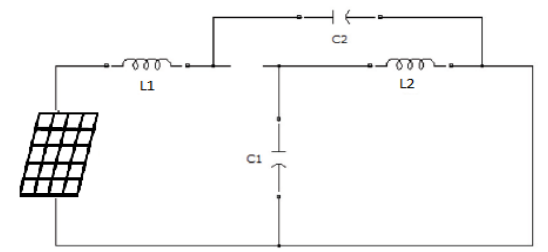
Fig.3: Shoot-through state of qZSI The basic relationships based on the operating states are given below: